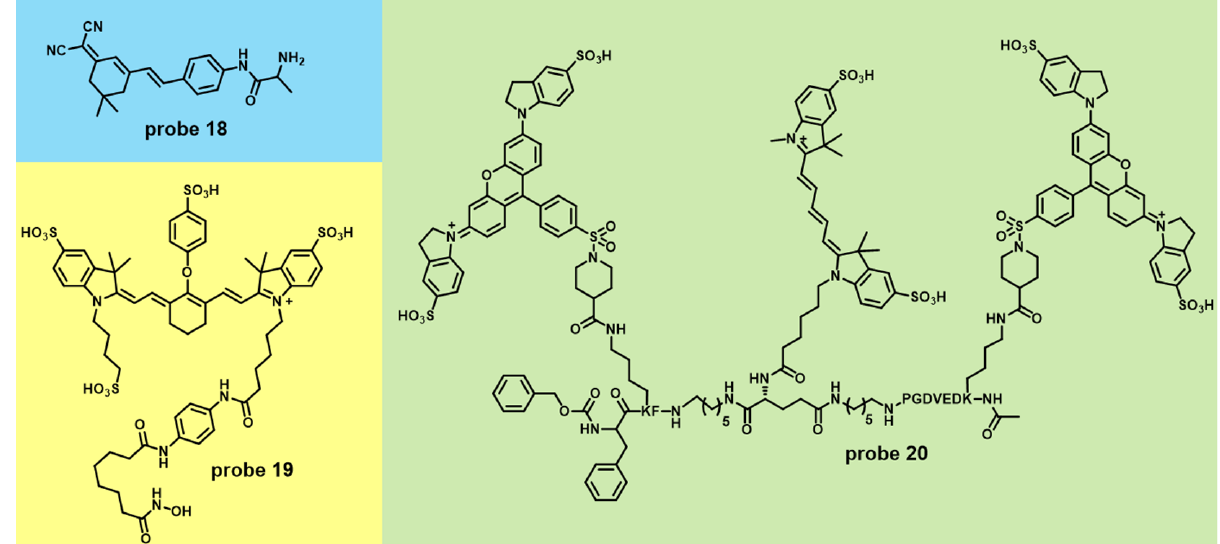
Figure 7. Chemical structures of probes 18 , 19 and 20 . Table 1. The basic information of listed probes in the main text.